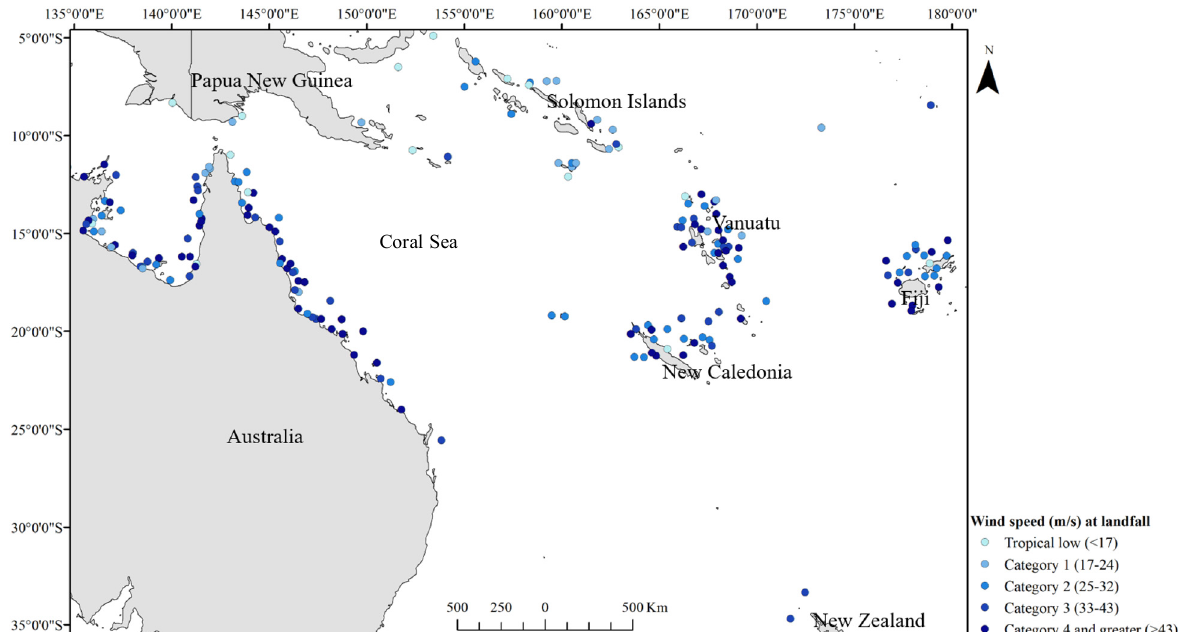
Figure 1. Landfall location of Australia mainland landfall TCs and SWPO island landfall TCs from 1980 to 2018. Intensity at landfall is color–coded following the BoM Australia tropical cyclone scale .